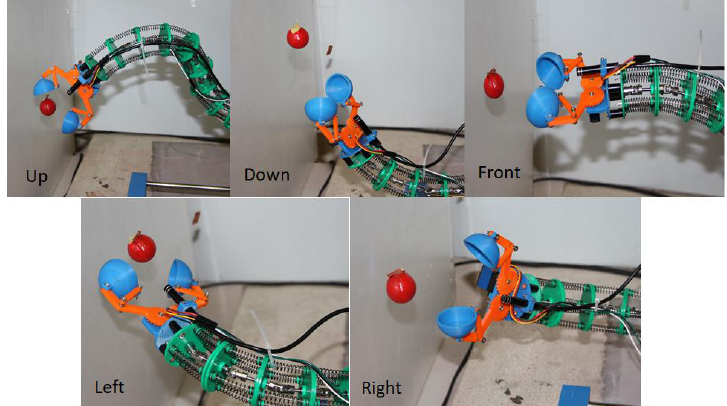
Figure 23. TakoBot object reaching angles.